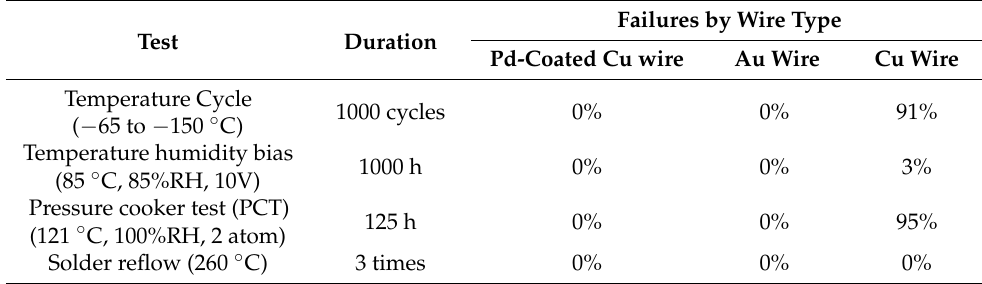
Table 2. Reliability test results: deteriorated ratios after tests [115]. Copyright, 2006, IEEE. Failures by Wire Type Test Duration Pd-Coated Cu wire Au Wire Cu